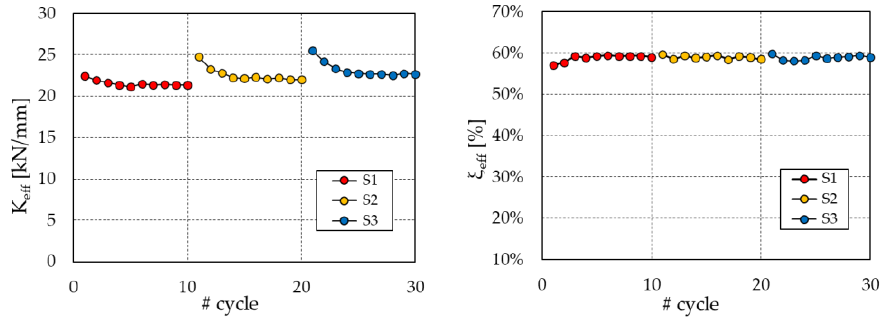
Figure 5. Changes in K eff and ξ eff during the tests S1, S2, and